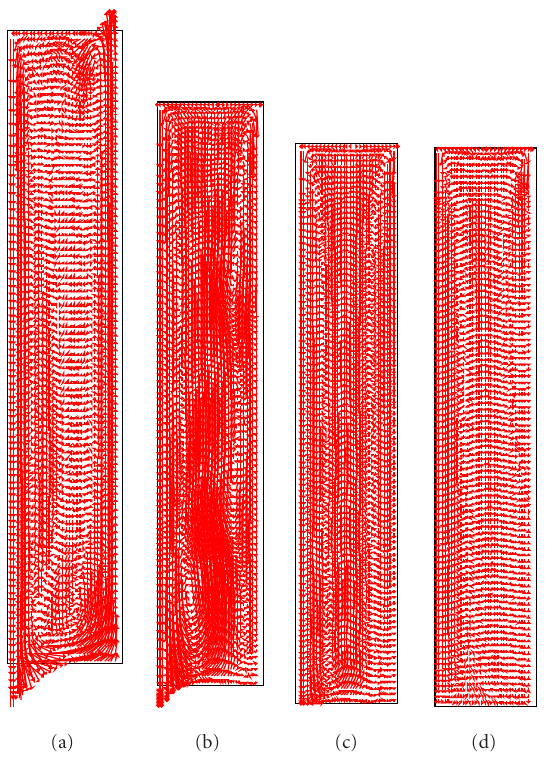
Figure 2: Velocity vector on meridional plane in drum under spin- down process from 5s/rev to zero, (a) t = 0 seconds, (b) t = 6 seconds, (c) t = 20 seconds and (d) t = 40 seconds.